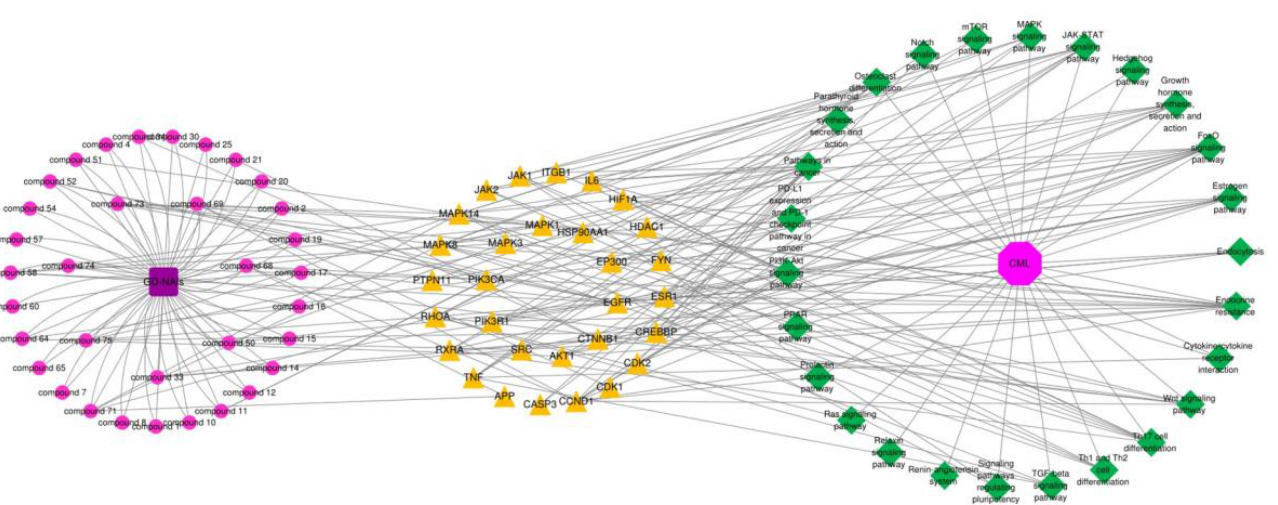
Figure 5. The KEGG pathways associated with GD-NAIs against CML.